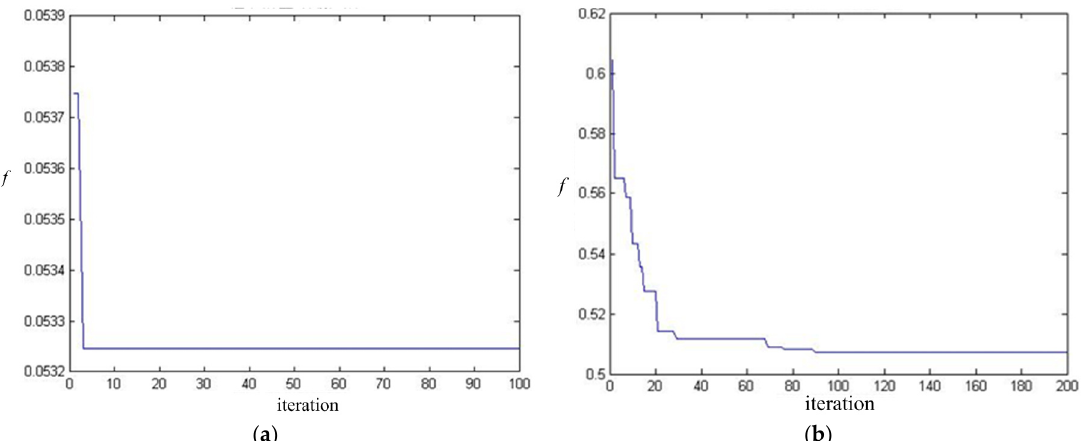
Figure 5. Convergence characteristics of proposed method of the IEEE 37-bus test system: ( a ) the first stage; ( b ) the second